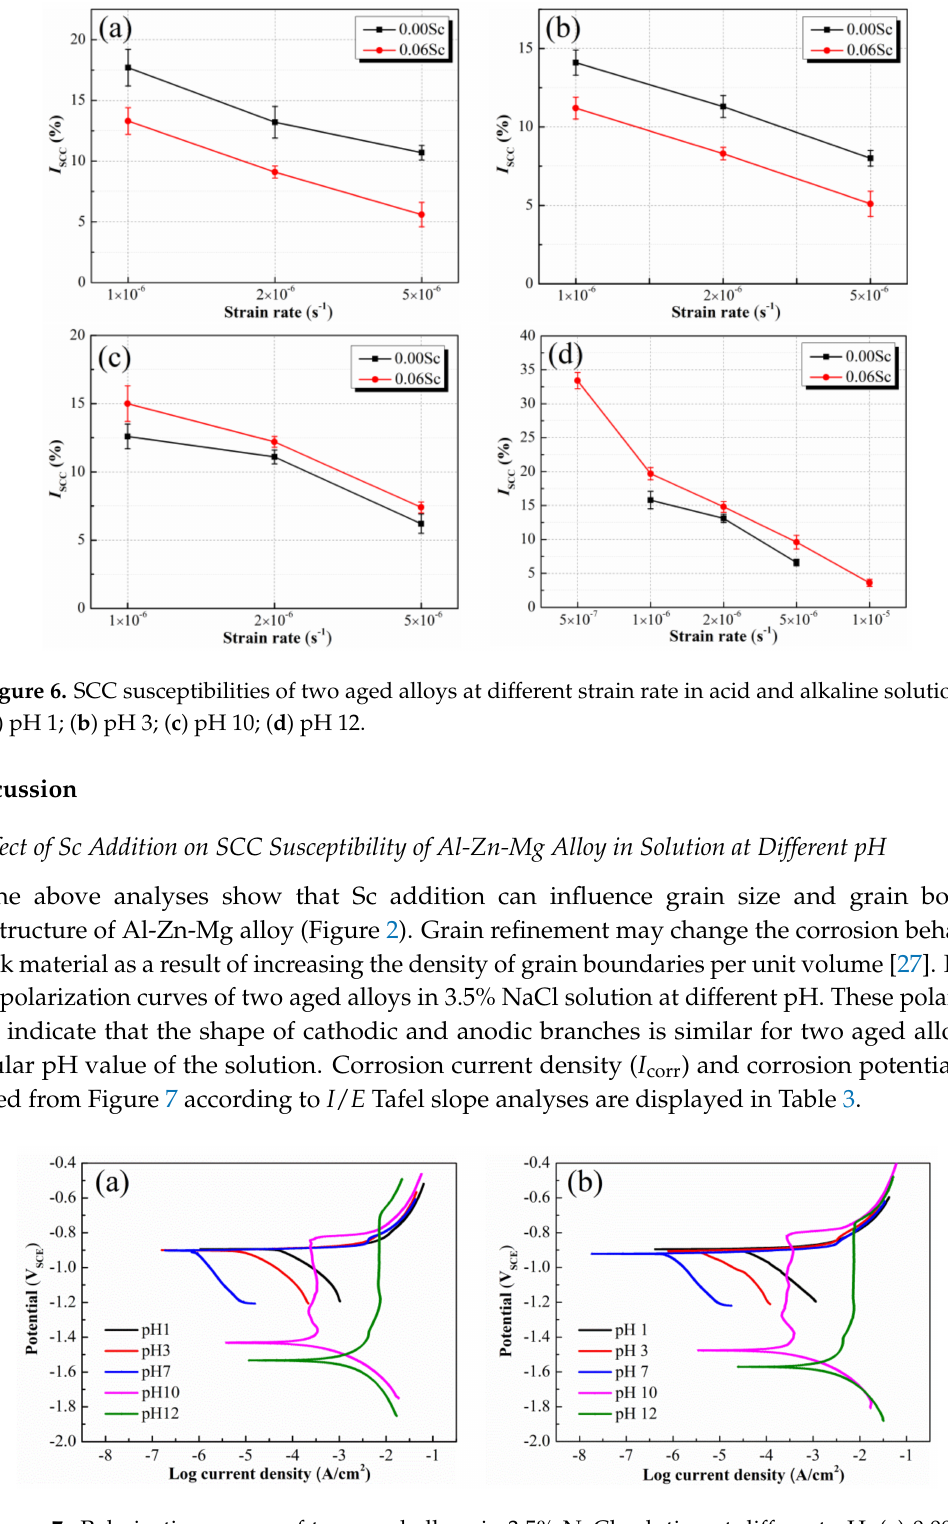
Figure 7. Polarization curves of two aged alloys in 3.5% NaCl solution at different pH: ( a ) 0.00Sc; ( b )